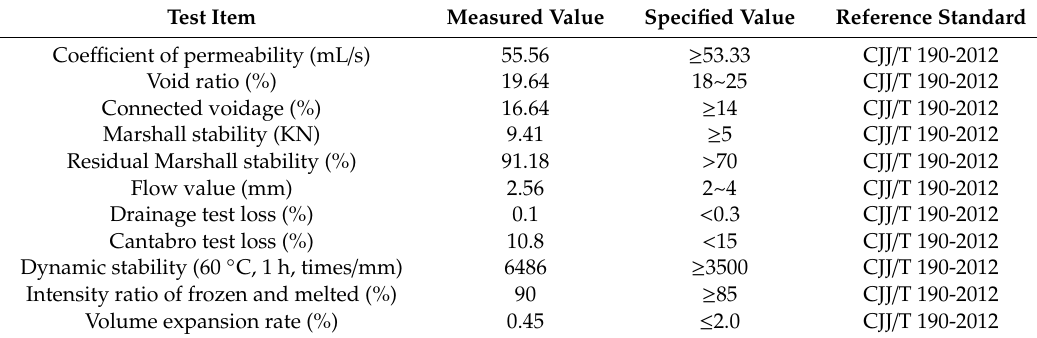
Table 4. Road performance of permeable steel-slag–bitumen mixture (PSSBM).